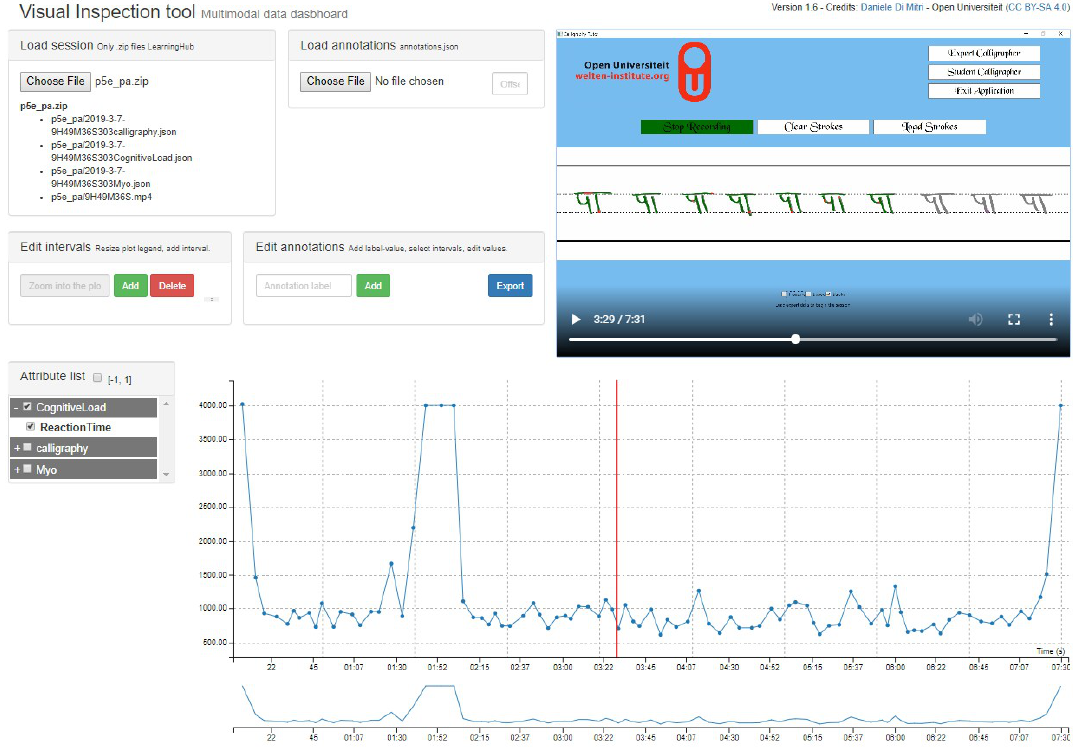
Figure 5. Visual Inspection tool for providing summative